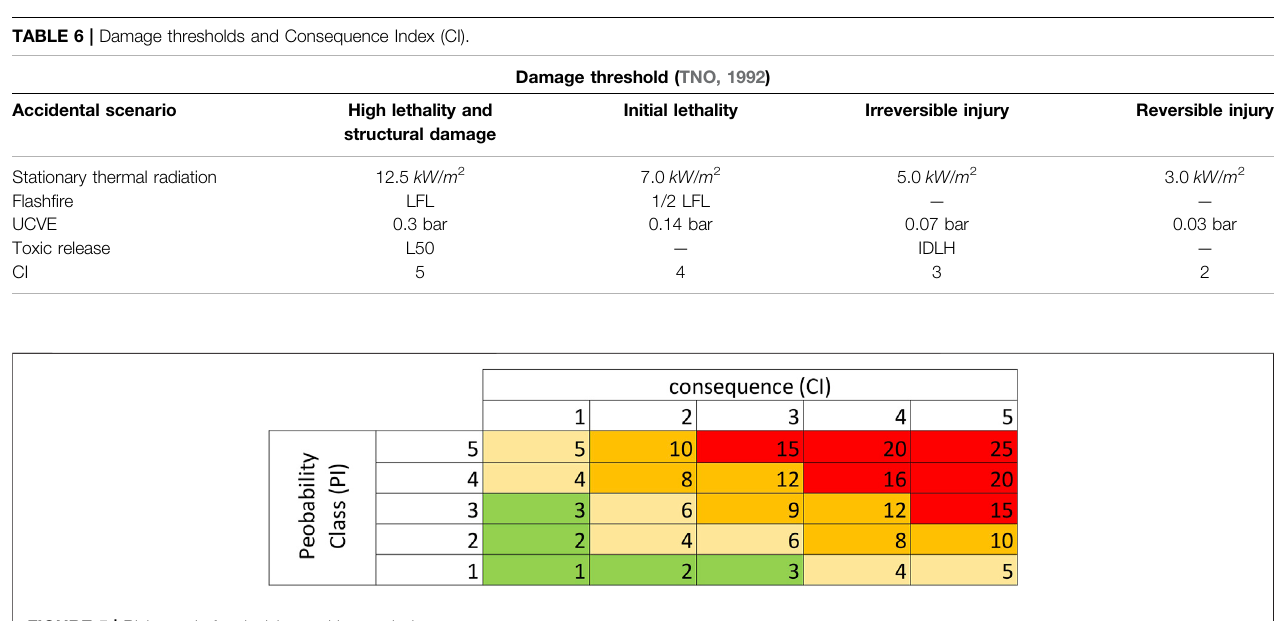
FIGURE 5 | Risk matrix for decision-making